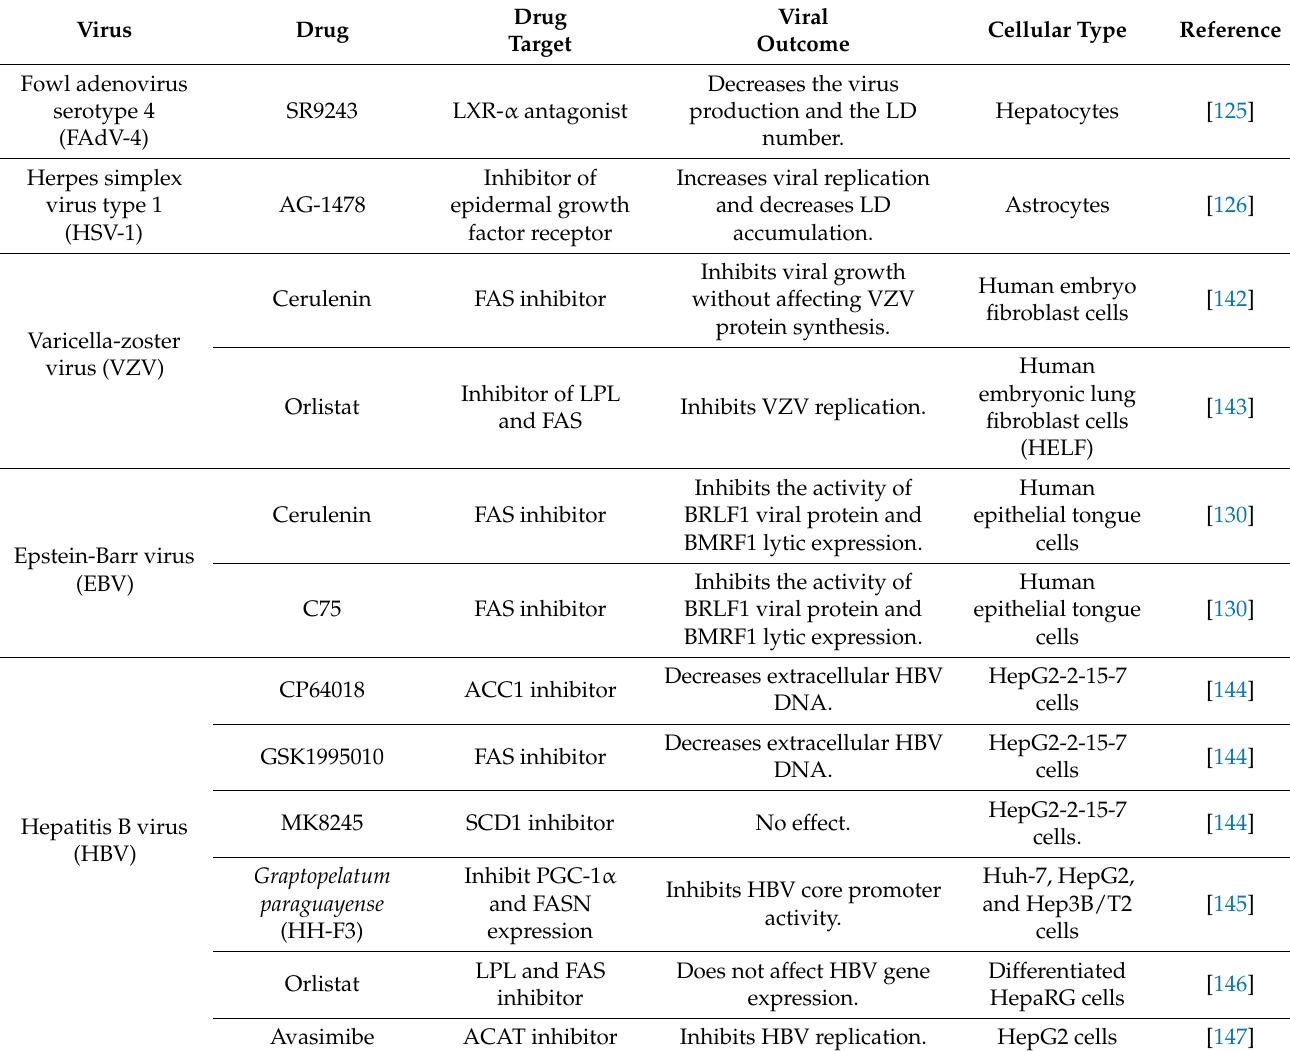
Table 2. Effects of lipid pharmacological modulation in the replicative cycles of viral infections.